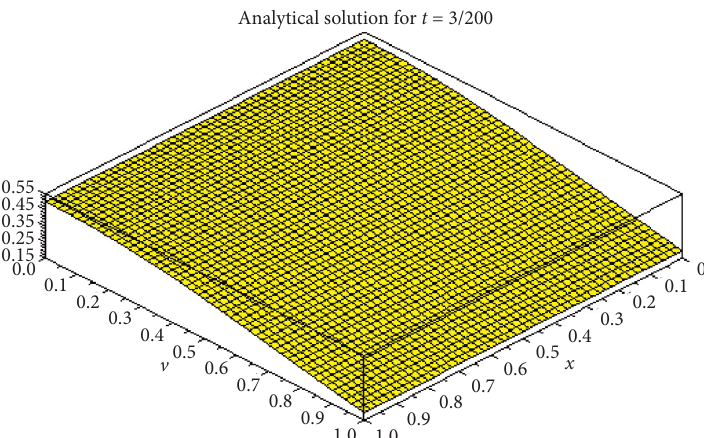
( x, v ) for h � 1/100. 1